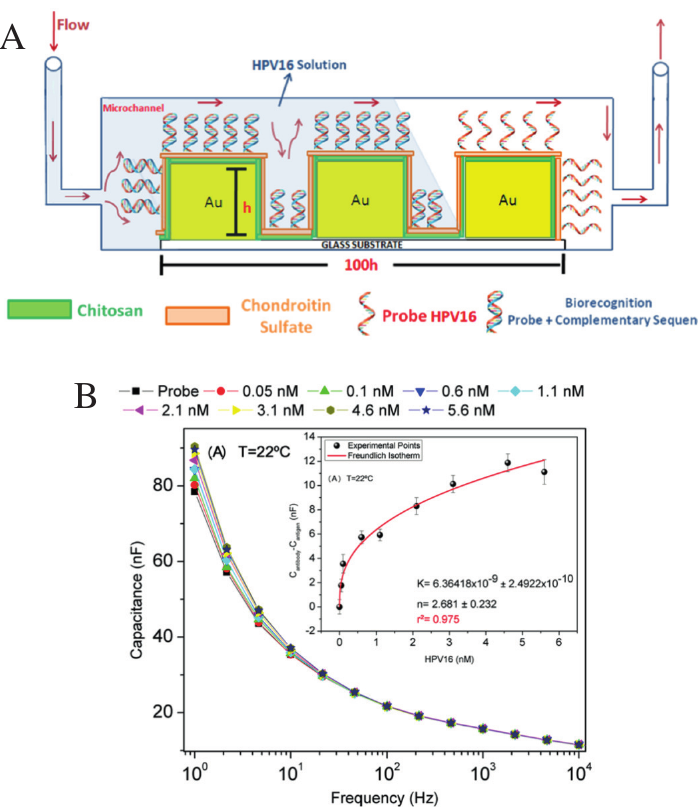
Figure 5. ( A ) Picture of the electrode functionalization and detection of HPV16 under continuous flow. ( B ) Capacitance spectra measurements at a hybridization temperature of 22 ◦ C for different concentrations of ssHPV16-positive. The calibration curve is presented in the inset. Reproduced with permission from Ref. [68]. Copyright 2018 American Chemical Society.